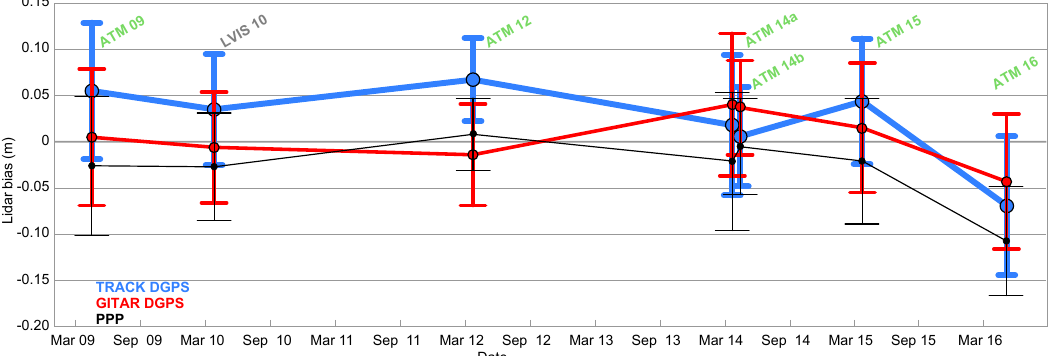
Figure 4. Performance of ATM and LVIS over Summit Station through time. Date versus lidar surface bias (m), for ATM and LVIS, for the IceBridge campaigns. Error bars represent surface measurement precision. TRACK DGPS (blue), GITAR DGPS (red), and Inertial Explorer PPP (black) GPS post-processing results are presented. ATM 15 represents the narrow-scan lidar system only. We note that for the GITAR solutions, the base station positions represent an average of four days of data; for the TRACK solutions, the base station positions represent an average recorded over the duration of the ground-based survey. This may account for the slight offset associated with the TRACK